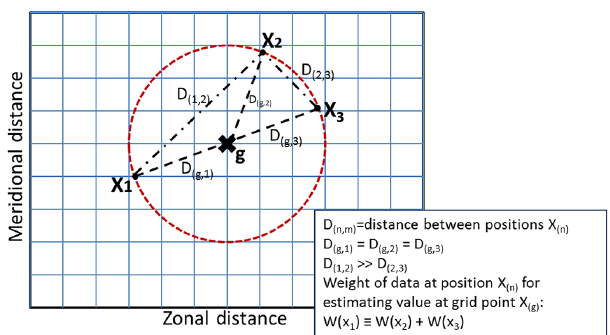
Figure 6. In objective mapping, the profile data are weighted based on their distance D to the grid point g , as well their distance to neighbouring profiles. Thus, while profiles x 1 ,x 2 and x 3 are all equally distanced from the grid point g , x 2 and x 3 are more closely spaced to each other than they are to x 1 . Thus, the weight of x 1 would be equivalent to the sum of weights for x 2 and x 3